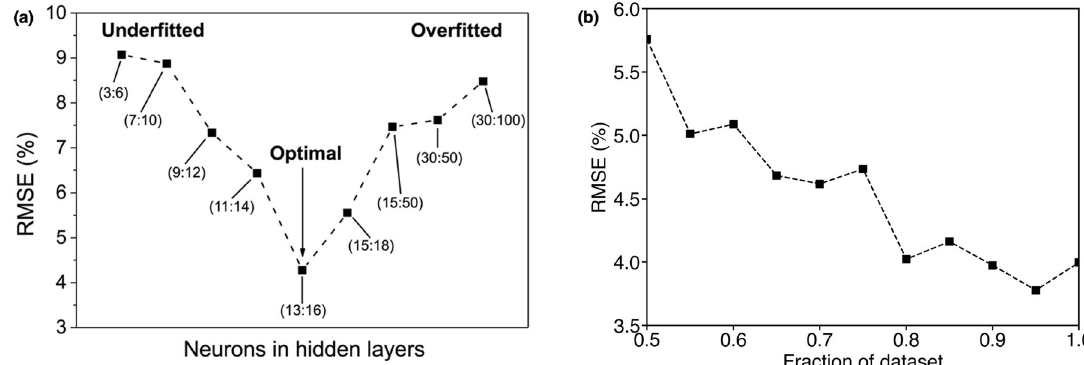
Fig. 3 Optimization of machine learning models. RMSE values are plotted for a different NN architectures and b fraction of dataset for the combined model. a The number of neurons in the hidden layers increases from left to right on the horizontal axis and the numbers in parenthesis represent the number of neurons in the fi rst and second hidden layers, respectively. b RMSE values for the combined model when using a partial